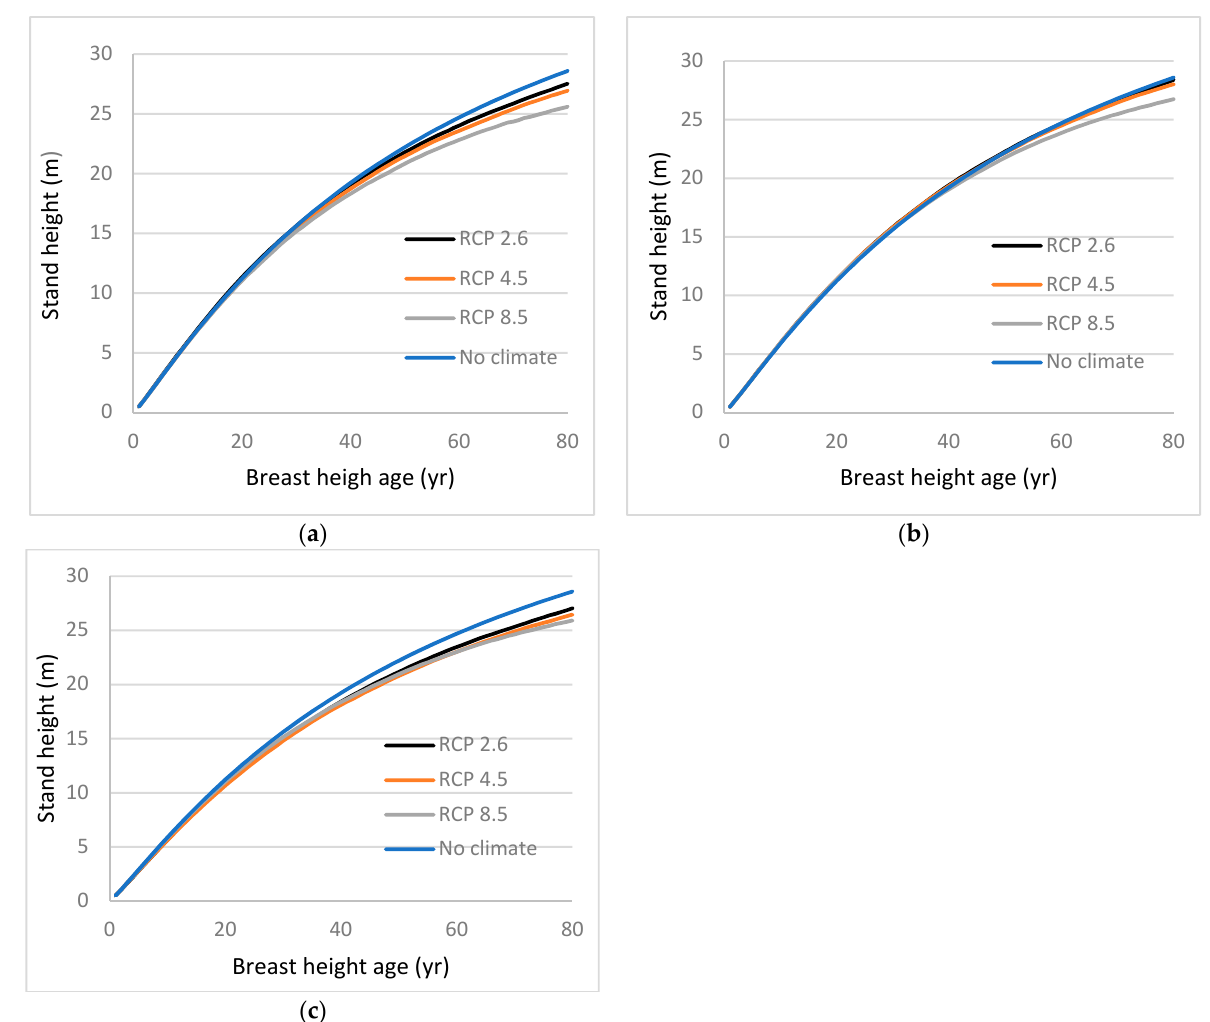
Figure 4. Stand height profiles for red pine trees generated using projected values of climate variables for the period 2021 to 2080, assuming climate remains stable (no climate) or warms (RCPs 2.6, 4.5, and 8.5), in Equation (4) for ( a ) southeastern (near Barrie), ( b ) central (near Hearst), and ( c ) western (near Red Lake) Ontario, Canada. Climate variables were projected for locations close to sample sites using three emissions trajectories known as representative concentration pathways (RCPs).